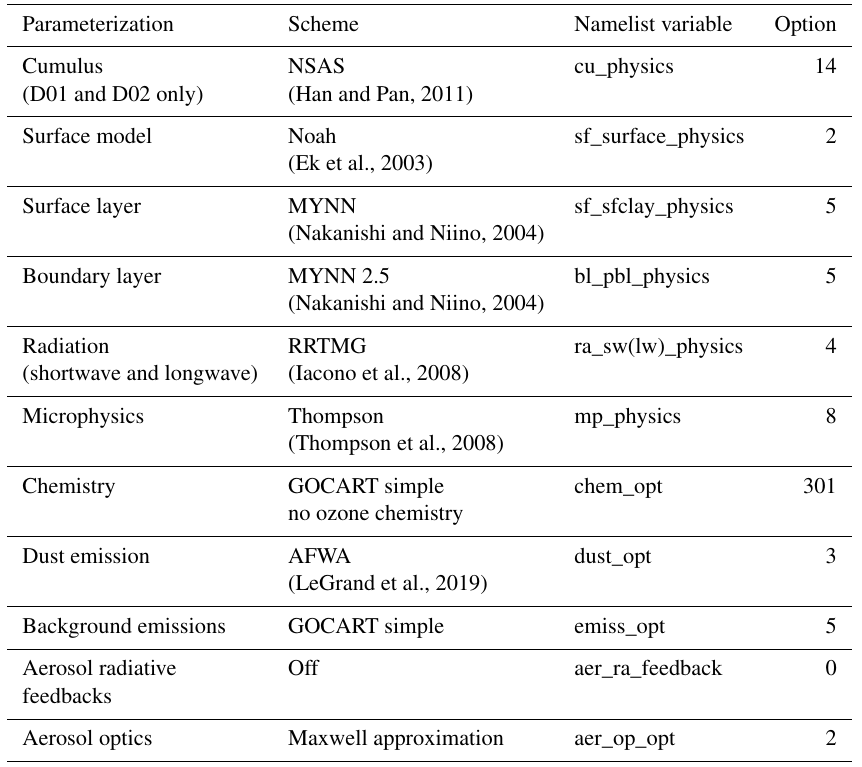
Table 3. WRF-Chem physics and chemistry parameterizations. Note that the option numbers may be different in later model versions. Parameterization Scheme Namelist variable Option Cumulus NSAS cu_physics 14 (D01 and D02 only) (Han and Pan, 2011) Surface model Noah sf_surface_physics 2 (Ek et al., 2003) Surface layer MYNN sf_sfclay_physics 5 (Nakanishi and Niino, 2004) Boundary layer MYNN 2.5 (Nakanishi and Niino, 2004) Radiation RRTMG ra_sw(lw)_physics 4 (shortwave and longwave) (Iacono et al., 2008) Microphysics Thompson (Thompson et al., 2008) Chemistry GOCART simple no ozone chemistry Dust emission AFWA Background emissions GOCART simple Aerosol